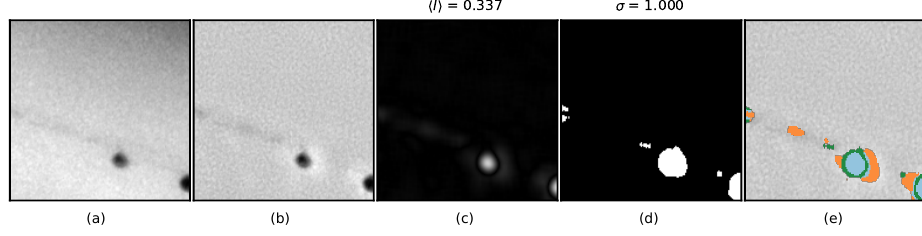
Figure 5. Results for the high contrast real defects test dataset; ( a ) is input, ( b ) is the residual image, residual analysis kernel results are for average kernel in ( c ) and standard deviation in ( d ). Above the patch is the maximum value indicated. Kernels above thresholds are indicated in ( e ) with blue ( (cid:104) I (cid:105) and σ ), green ( σ ), and orange ( (cid:104) I (cid:105) ).